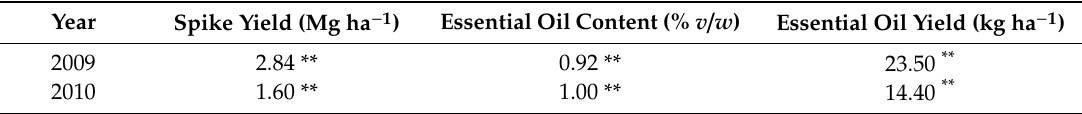
Table 4. Year averages for floral spike and EO yields.